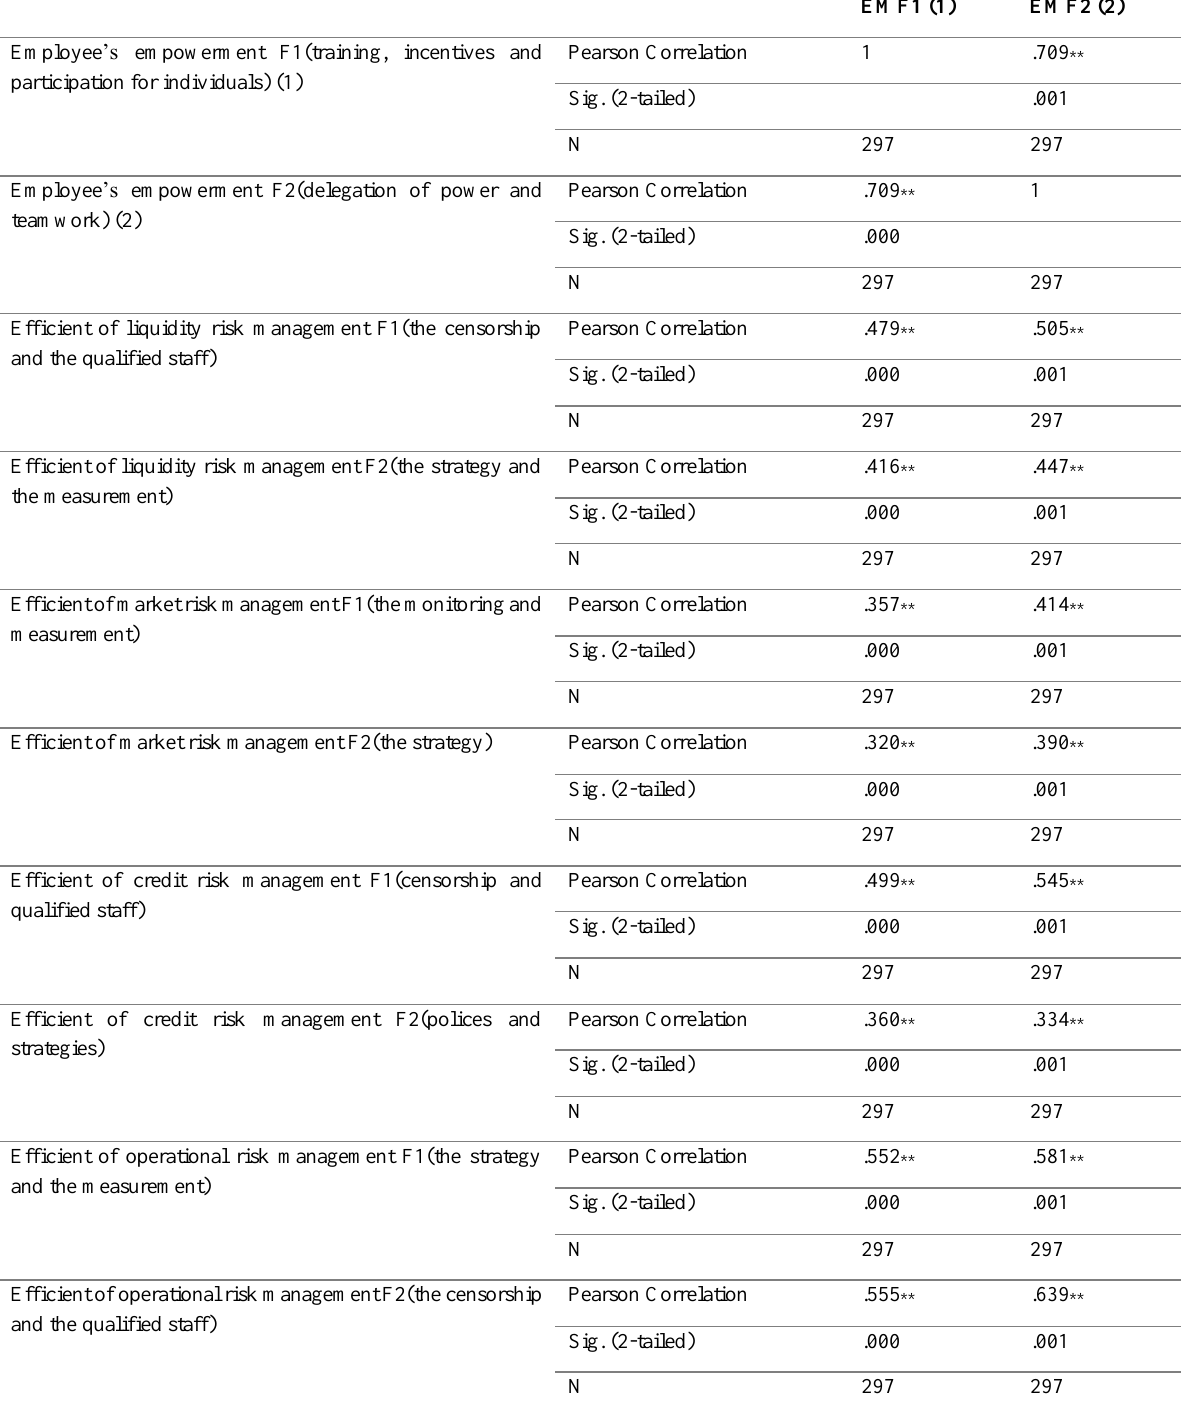
Table 5: Correlation between sub variables of employee’s empowerment and sub variables of efficient risk management